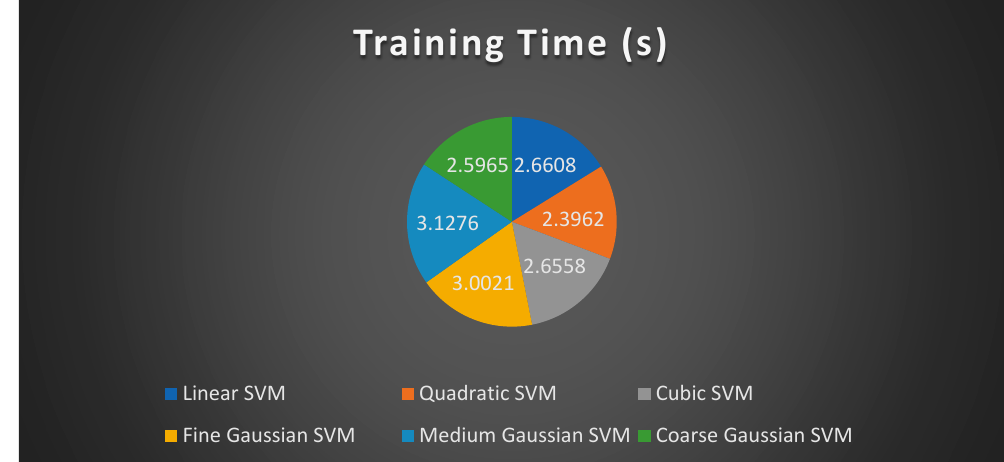
Figure 6. Training time of 550 features.